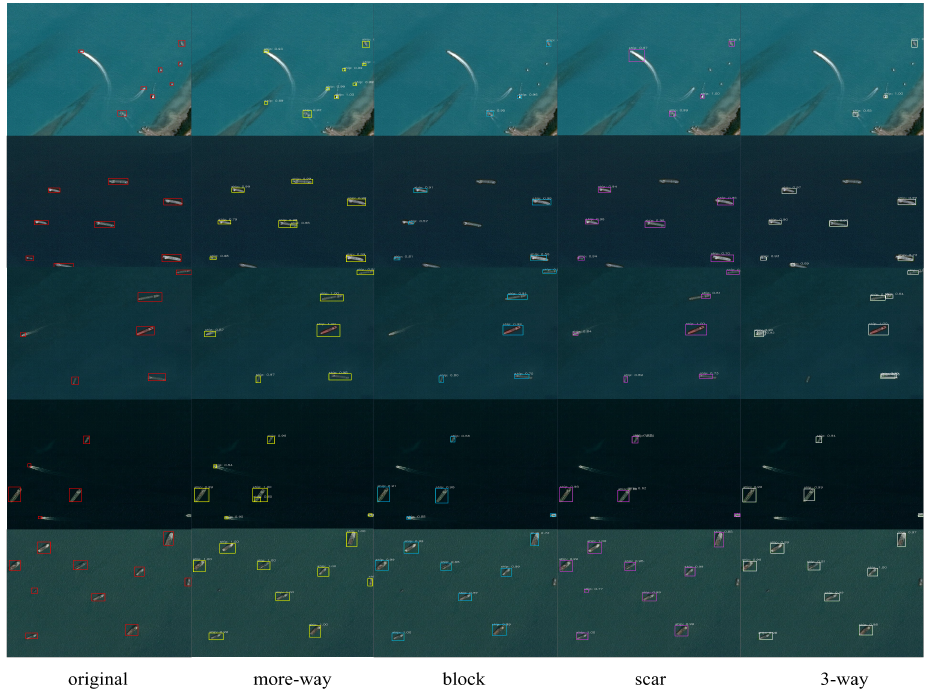
Figure 7. Detected objects by SS R-CNN with various CutPaste tasks in different images. Detection frames of different methods are depicted with different colors.